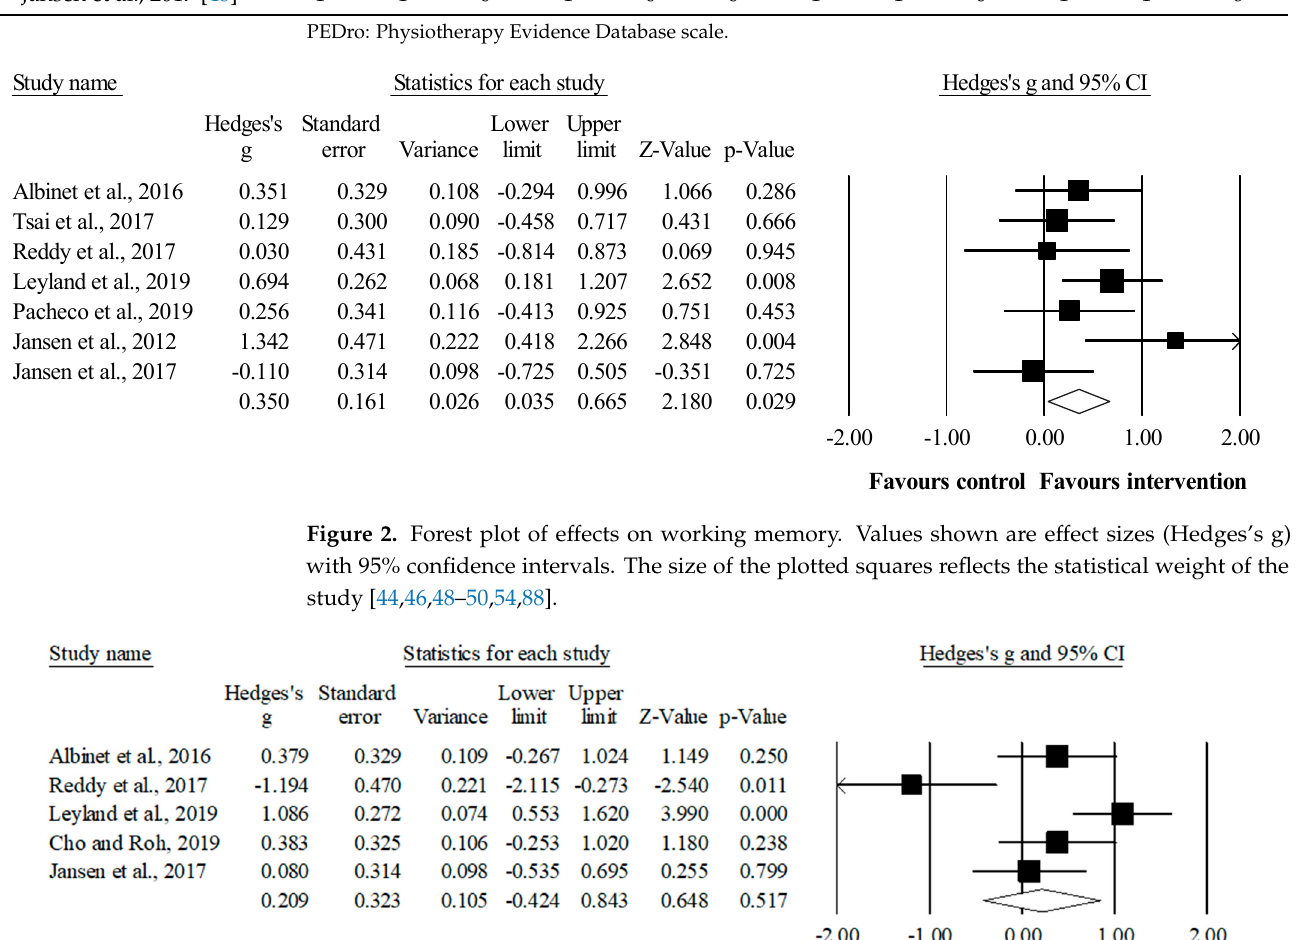
The meta-analysis for working memory involved seven studies, seven experimental groups ( n = 139), and seven control groups ( n = 116). Compared to the control group, a small but favoring significant effect was observed in the intervention group (ES = 0.35, 95% CI = 0.04–0.67; p = 0.029; I 2 = 36.7%). A sensitivity analysis (each study removed from the analysis once) indicated that the exclusion of three studies [44,49,88] affected the re- sults of the meta-analysis (ES = 0.27–0.37; 95% CI = − 0.08–0.74; p = 0.052–0.127; I 2 = 30.6– 47.3%) (Figure 2).